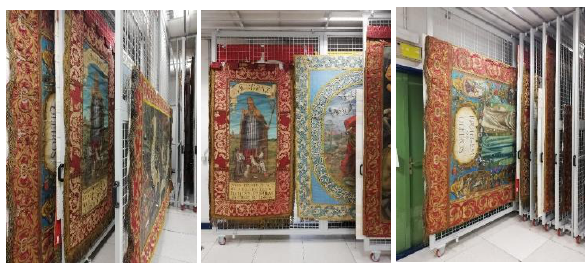
Figure 21 - An overview of some grids with banners fixed. Flat hooks were placed on the lower edge of the Tycore ® boards, fixing it to the grid and supporting the weight of the set and rounded hooks were placed on the upper edge, simply to adjust the set to the grid, protected with a protective cell-air strip interlayer between the hook and the object (Figure 22).